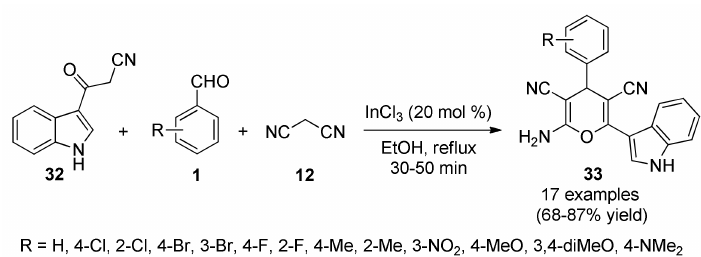
against Gram-positive and Gram-negative